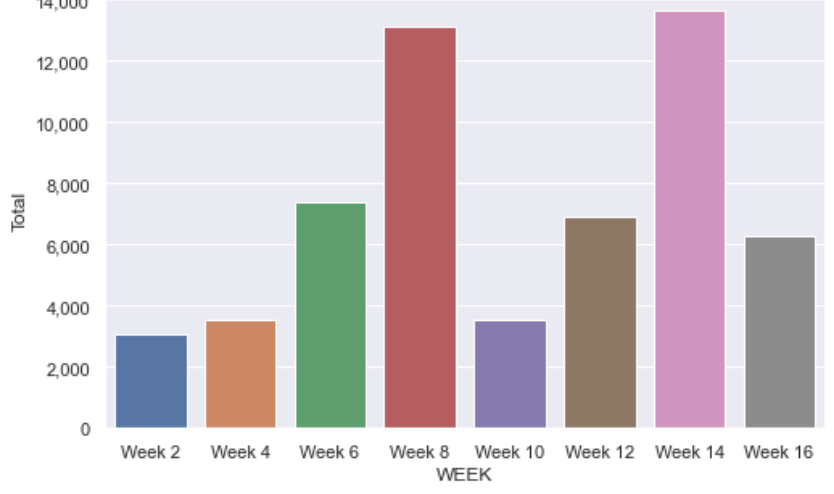
Figure 5. Interactions per weeks.